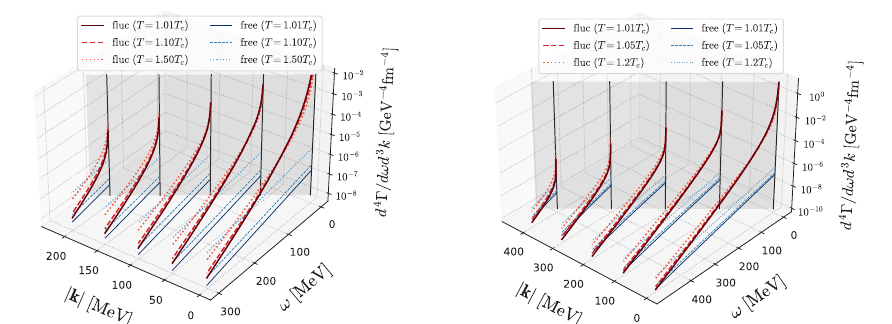
Figure 2: DPRs per unit energy ω and momentum k above T c of the 2SC at µ = 350 MeV (left) [4] and of the QCD CP at µ = µ CP (right). The thick lines are the contribution of the soft modes, and the thin lines are the results for the free quark